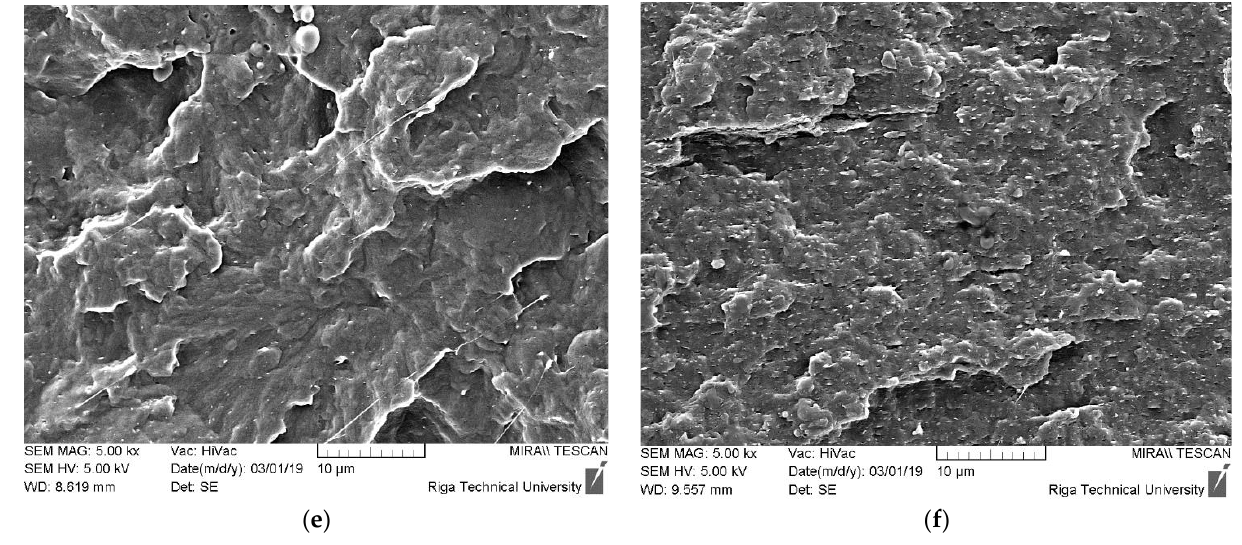
Figure 3. Surface morphology of C ( a ), M ( b ), and PP ( c ); its composites with 0.5%C and MAH ( d ), 0.5%M and MAH ( e ), and 5%M and MAH ( f ).